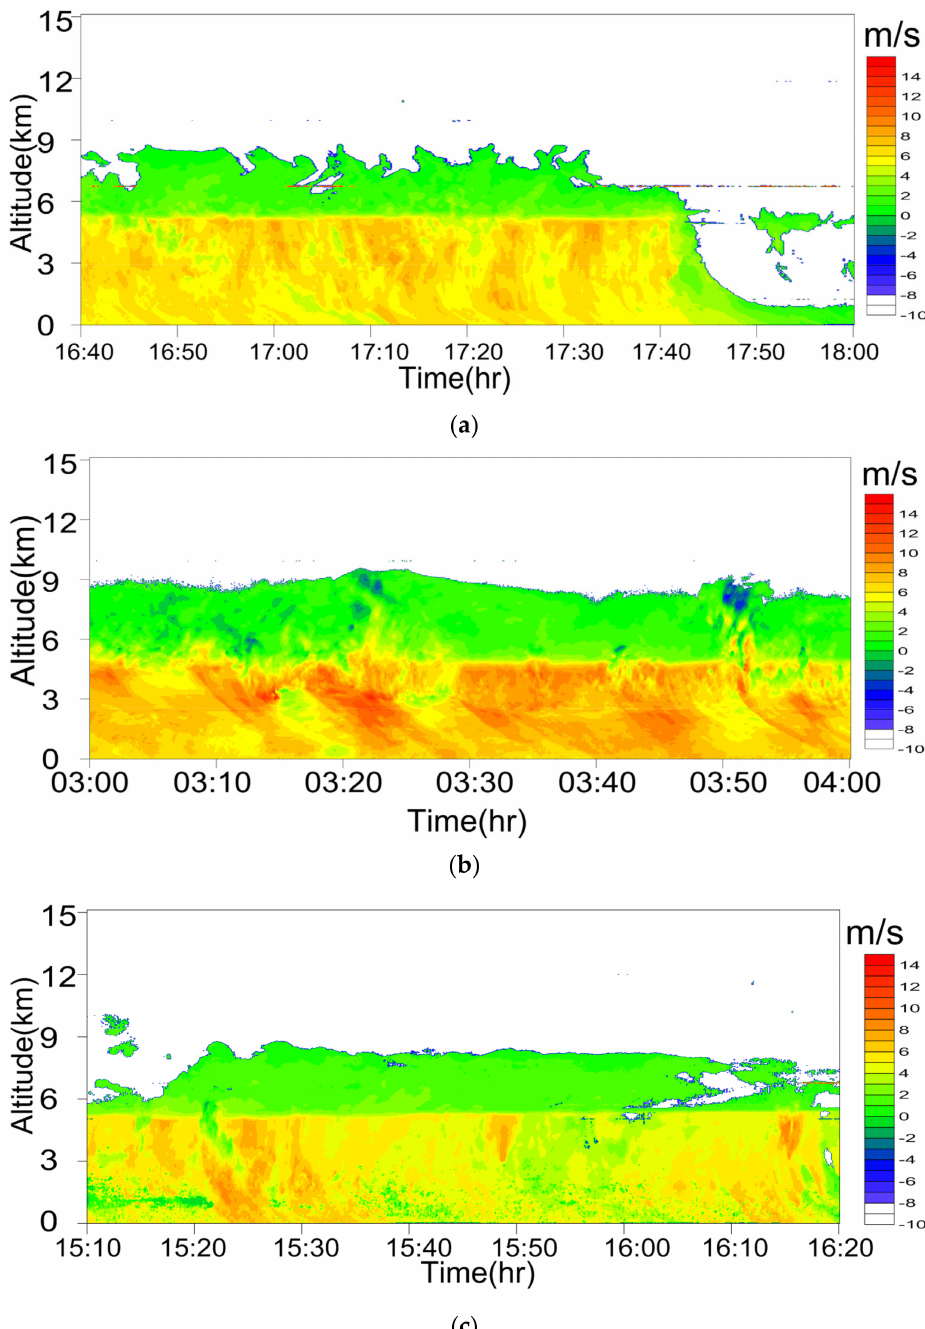
Figure 6. The vertical velocity of particles detected by the C-FMCW radar (positive velocity is downward) ( a ) 22 June; ( b ) 28 June; ( c ) 11